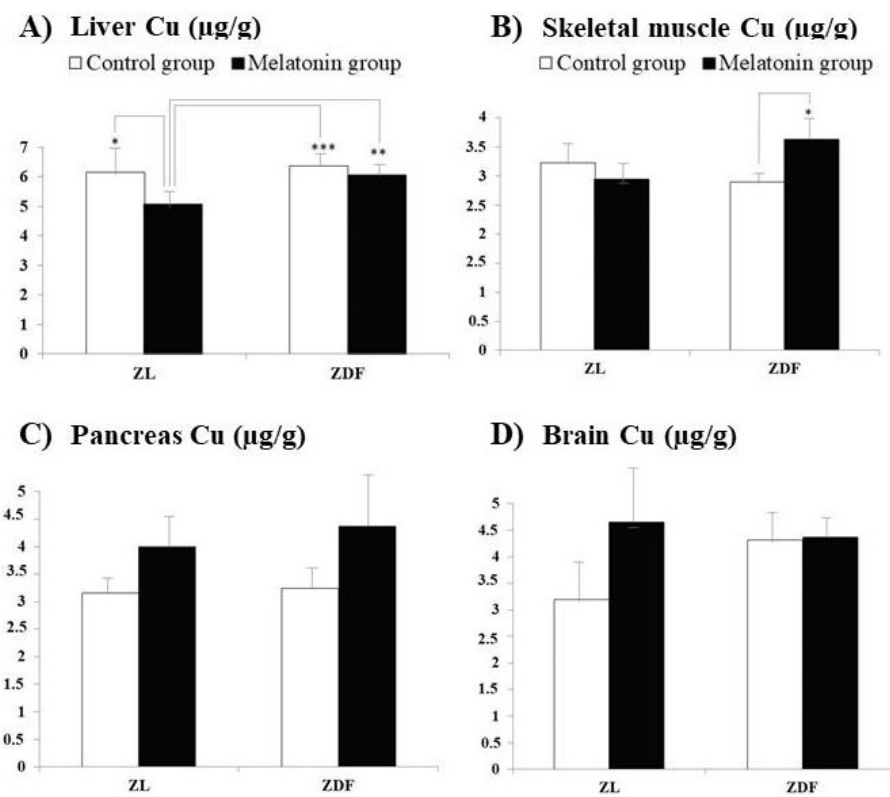
Figure 3. Influence of melatonin supplementation in Cu levels of different organ tissues in male Zücker lean and diabetic fatty rats. ( A ) Liver Cu. ( B ) Skeletal muscle Cu. ( C ) Pancreas Cu. ( D ) Brain Cu. C–ZL: Control lean rats without melatonin; M–ZL: Lean rats with melatonin; C–ZDF: Control diabetic fatty rats without melatonin; M–ZDF: Diabetic fatty rats with melatonin; ZL: Zücker lean rats; ZDF: Zücker diabetic fatty rats. Values are means ± SEM ( n = 10) of ratios of Zn levels. * p < 0.05; ** p < 0.01; *** p < 0.001 (Tukey post hoc test). For Cu, in ZDF rats, the supplementation with melatonin significantly increased con- centrations only in the muscle (C–ZDF vs. M–ZDF; Figure 3B; p < 0.05). In addition, in the liver for both groups of ZDF rats significantly higher Cu concentrations than those mea- sured in melatonin-treated ZL rats were found (M–ZL vs. C–ZDF and M–ZDF; Figure 3A; p < 0.001 and p < 0.01, respectively). Moreover, in the liver Cu concentrations measured in melatonin, the treated ZL rats were significantly lower to those found in the non-treated ZL group (M–ZL vs. C–ZL; p <